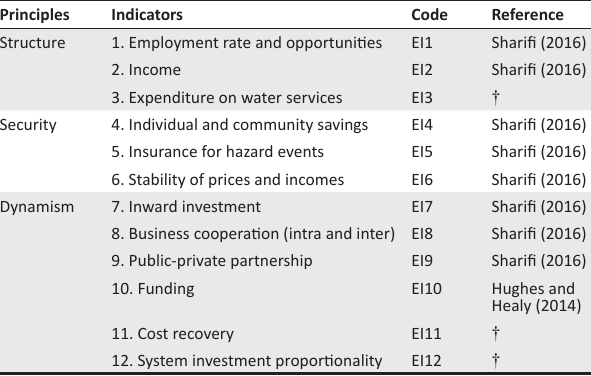
TABLE 5: Improved tool from the pre-assessment